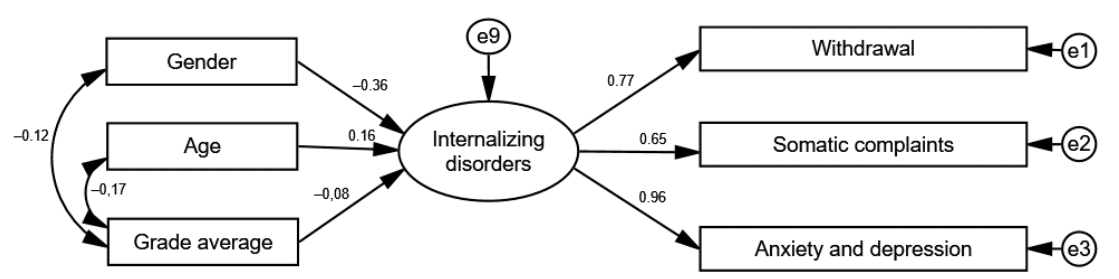
Figure 2. Standardized regression coefficients for the model of relationships between gender, age, and grade average and the YSR total score.